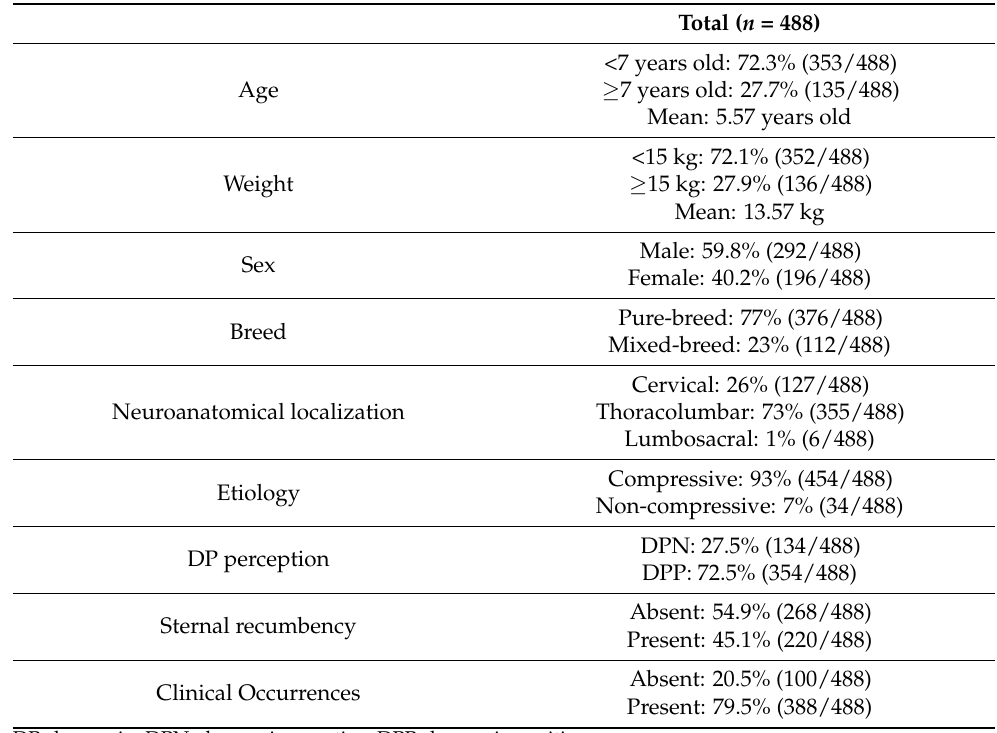
Table 1. Sample characterization of the study